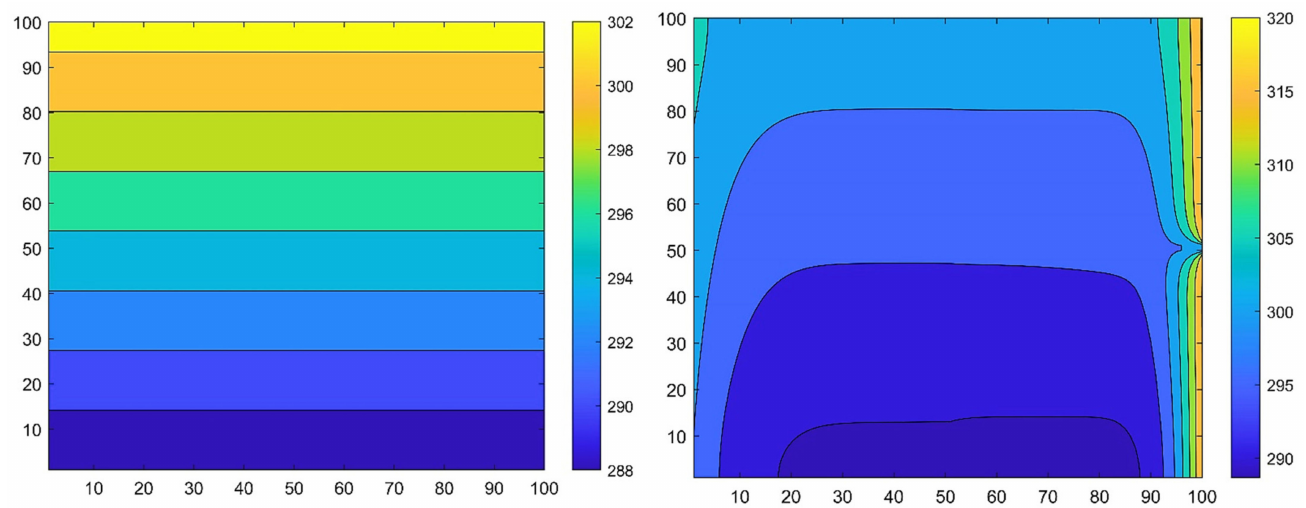
Figure 16. The temperature distribution contour for the equidistant mesh at initial ( left ) and final time ( right ) in the case of a multilayer cross-sectional area with thermal bridging.